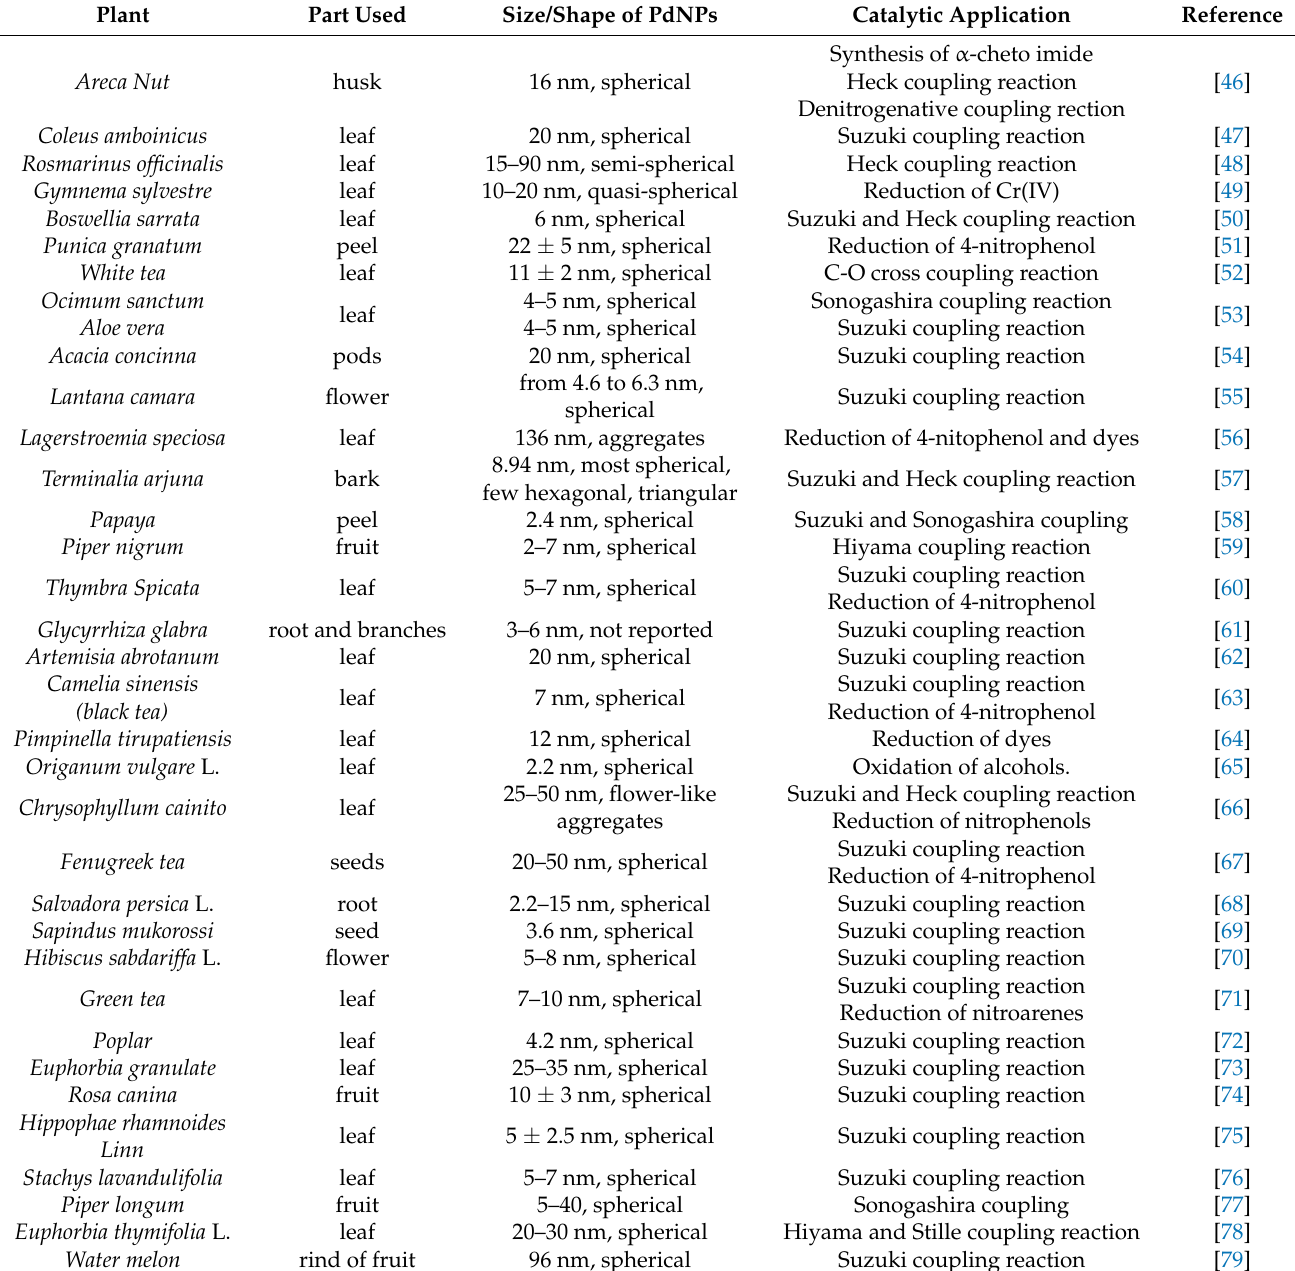
Table 1. Green synthesis of PdNPs by various part of plant extracts and their applications.